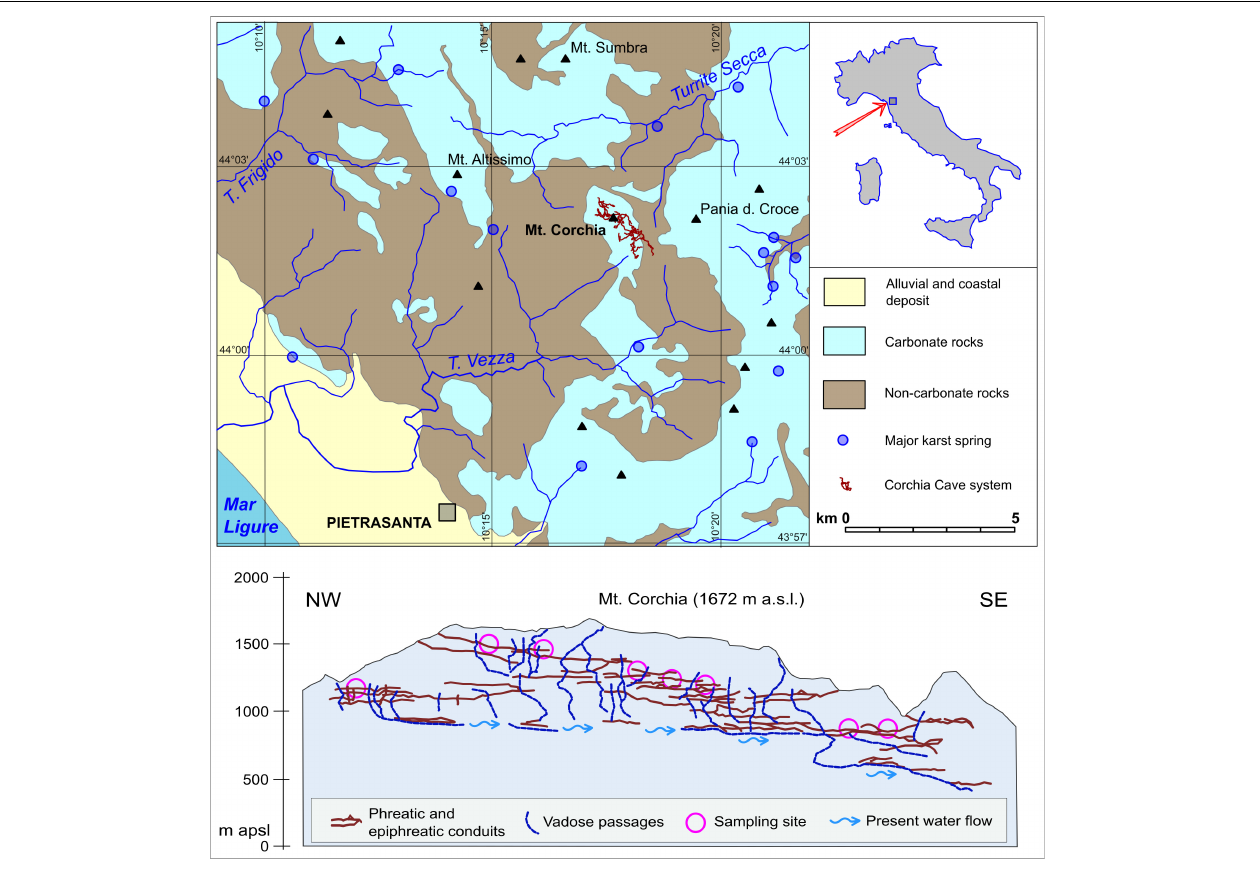
FIGURE 1 | Location map of Mt. Corchia area and schematic longitudinal profile of Corchia cave system with the position of sampling